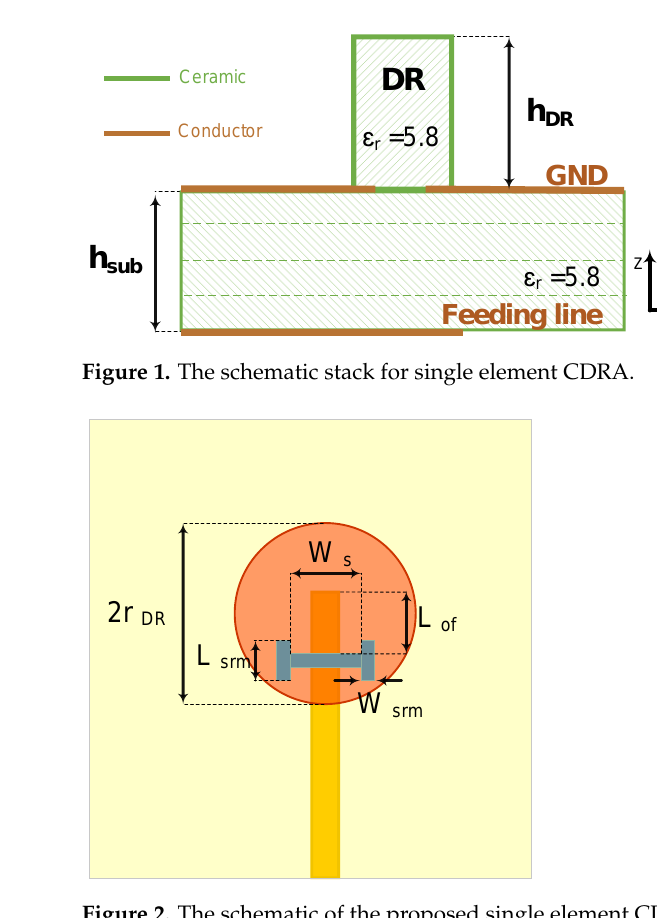
top schematic view in Figure 2. The design parameters consist of the substrate’s height, h sub , the resonator’s radius, r DR , and height, h DR , the feeding line’s width, w f , the dogbone slot’s dimensions, W s , L srm , and W srm , and the off-set of the slot from the end of the feeding line, L of .